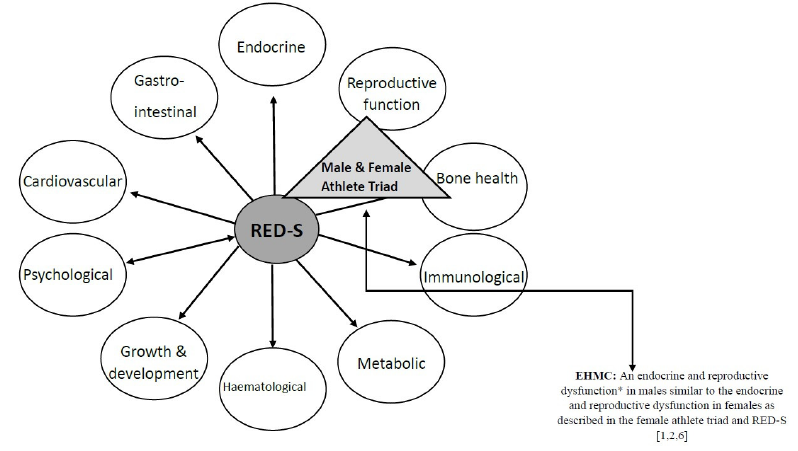
Figure 1. Adapted from the relative energy deficiency in sport health model [1,2] with the inclusion of the male and female athlete triad and the exercise-hypogonadal male condition [6]. Abbreviations: EHMC: exercise-hypogonadal male condition; RED-S: relative energy deficiency in sport *the exact physiological mechanism inducing the reduction of testosterone in men is currently unclear; it is postulated to be a dysfunction within the hypothalamic-pituitary-testicular regulatory axis.